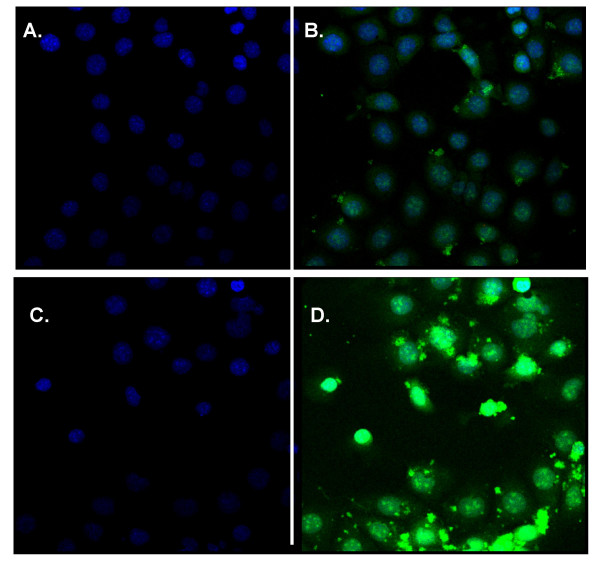
Distribution of FITC-labelled asODN in M1 cells in vitro. M1 cells were transfected with Lipofectamine 2000-complexed FITC-labelled asODN. At indicated time-points after transfection cells were harvested and processed for confocal microscopy. Nuclei were stained with DAPI and are shown in blue (left panel), FITC signal is shown in green (right panel). A and B show biodistribution 30 min after transfection, C and D show biodistribution 24 hrs after transfection.